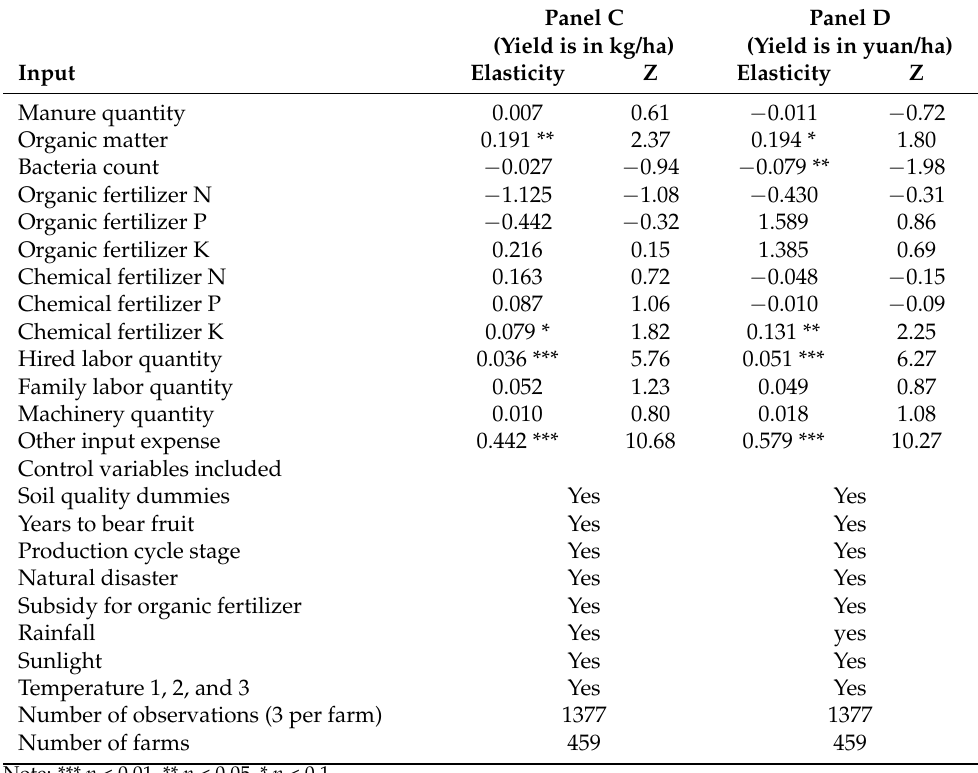
Table 5. Estimated mean values of partial output elasticities with inputs measured in physical units. Panel C Panel D (Yield is in kg/ha) (Yield is in yuan/ha) Input Elasticity Z Elasticity Z Manure quantity 0.007 0.61 − 0.011 − 0.72 Organic matter 0.191